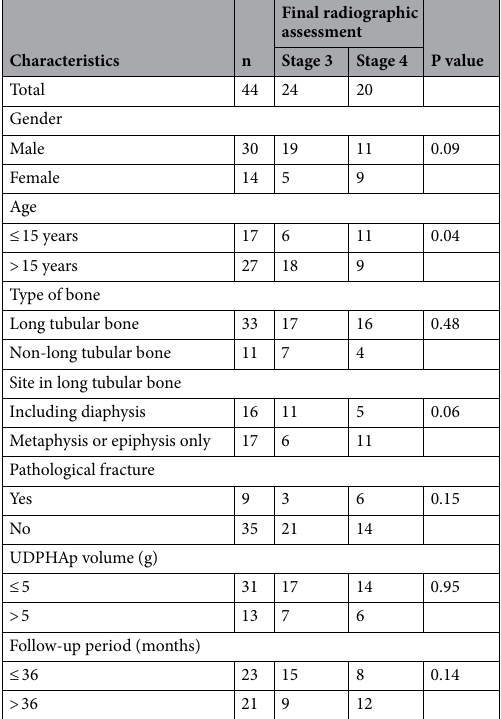
Table 1. Clinical factors influencing radiographic assessment at the final follow-up.